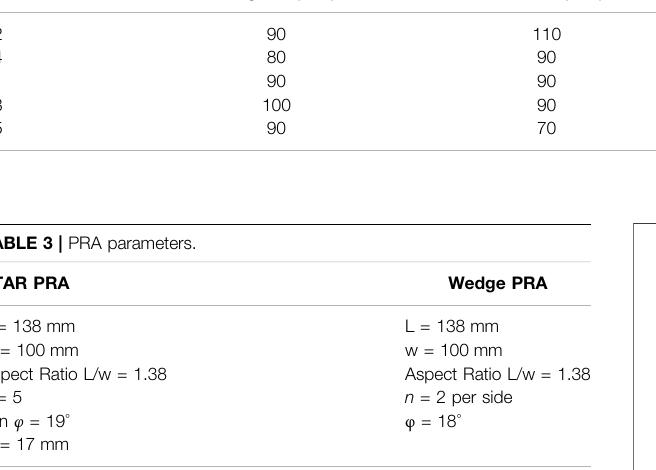
TABLE 2 | Aspect ratio and model error for varying PRA specimens. Specimen